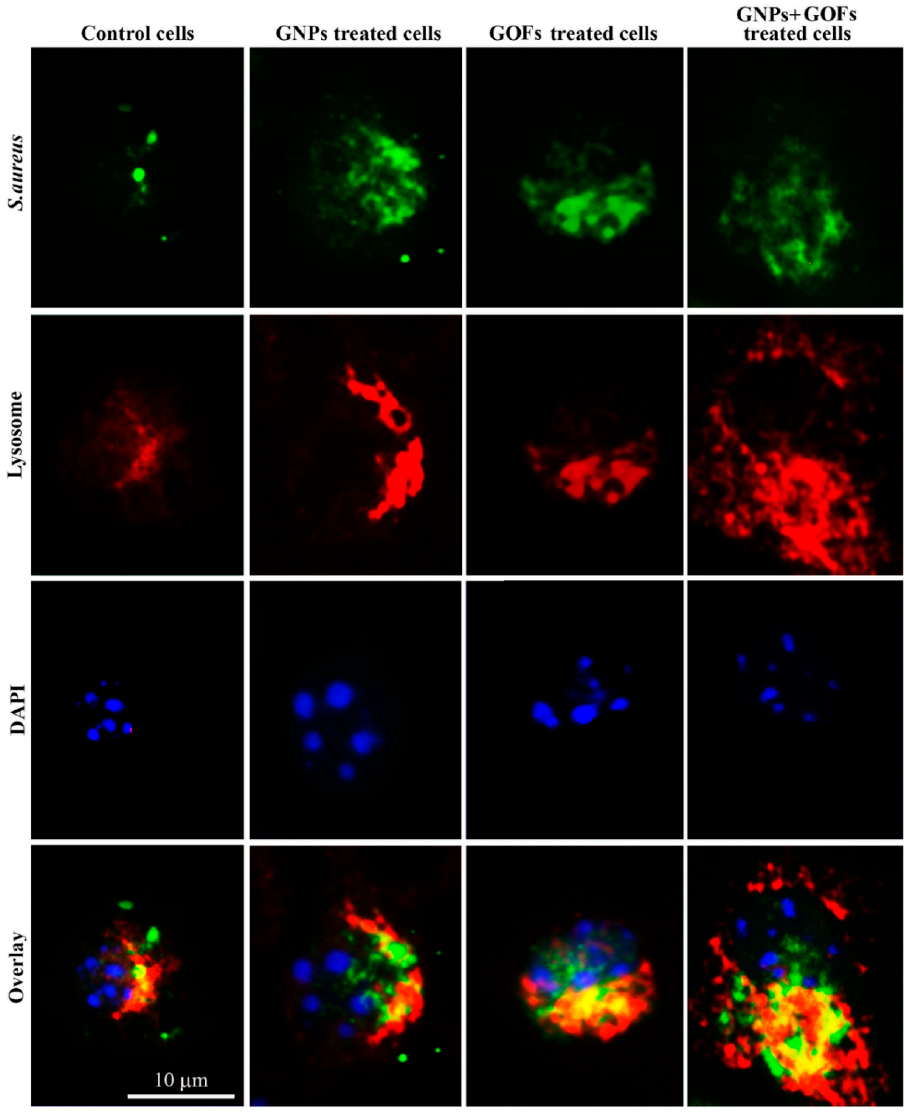
Figure 5. GNPs and GOFs enhanced co-localization between Lysotraker and Fluorescein isothiocyanate (FITC)-conjugated Staphylococcus aureus . Co-localization appeared in yellow, lysosomes labelled with Lysotracker appeared red, cell nuclei were stained with 4 ′ ,6-diamidino-2-phenylindole (DAPI) appeared in blue, scale bar, 10 µm. The scale bar is identical for all, as the magnifications are the same for the images.